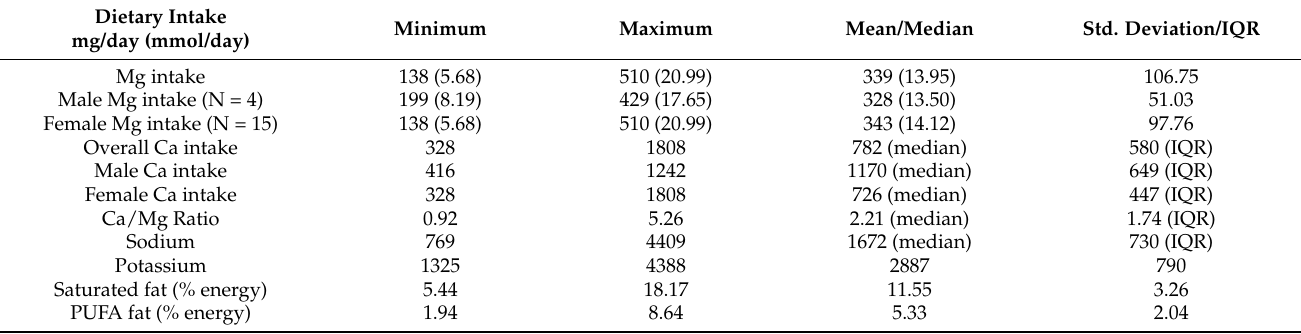
Table 2. Dietary